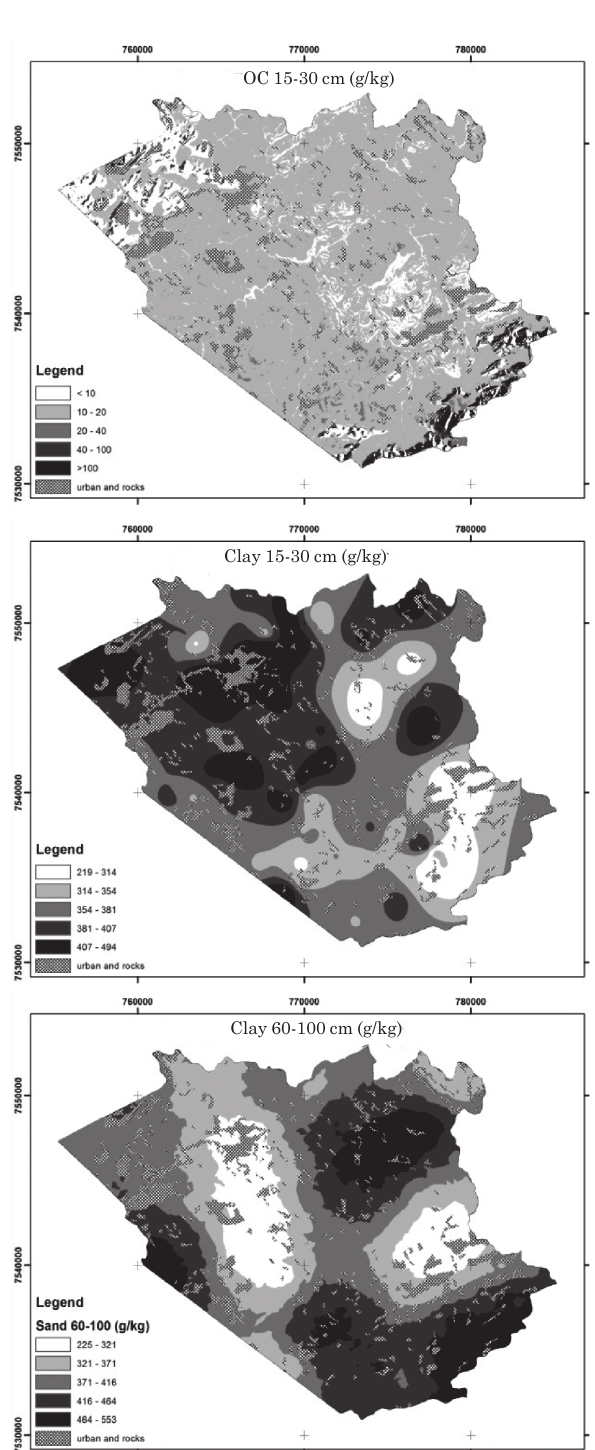
Figure 6. Distribution maps of OC and clay in the 15- 30 cm and of sand in the 60-100 cm layer of the study area.